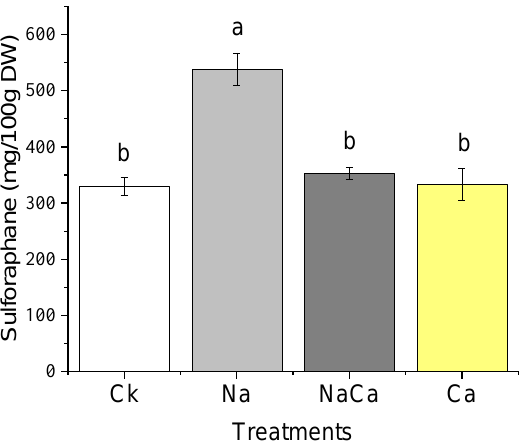
mmol L-1 CaSO 4 . Data are expressed as the mean ± standard deviation (SD), values labelled with different letters are significantly different ( p < 0.05).